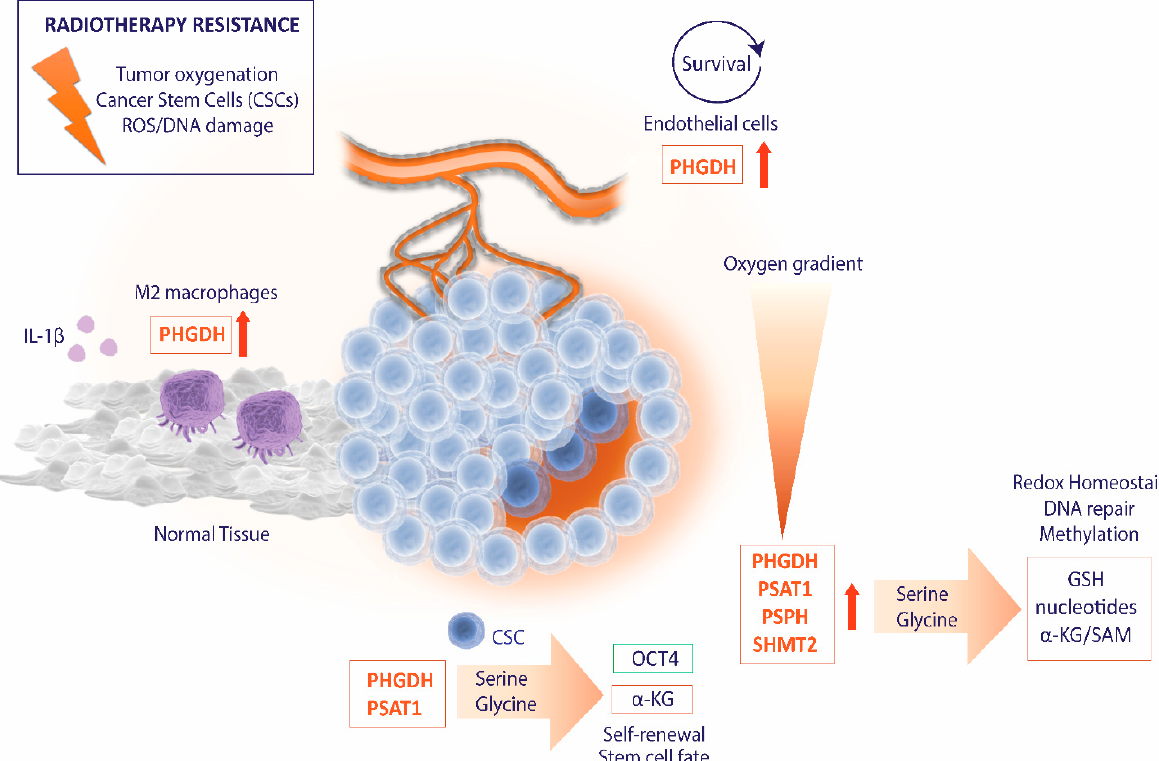
Figure 4. Linking radiotherapy resistance and serine/glycine metabolism in the tumor and associated tumor microenvironment. Activation of de novo serine/glycine biosynthesis pathway in cancer stem cells (CSC) under hypoxia and nutrient-deprived conditions is important to sustain cancer cell viability and proliferation, supporting the synthesis of nucleotides for DNA repair, as well as the synthesis of reductive equivalents that protect the cancer stem cells and their progeny against redox stress via autocrine and paracrine routes. In addition, de novo serine/glycine biosynthesis enzymes, i.e., PHGDH and PSAT1, are involved in the maintenance of CSCs stemness and self-renewal, for instance, via posttranslational regulation of OCT4, as well as regulating stem cell fate via α KG. In the tumor microenvironment, high PHGDH activity is essential for the survival of endothelial cells and promotes an immunosuppressive microenvironment with an increase in M2 macrophage polarization. In addition, serine and glycine are required for the expression of the pro-inflammatory cytokine IL-1 β .